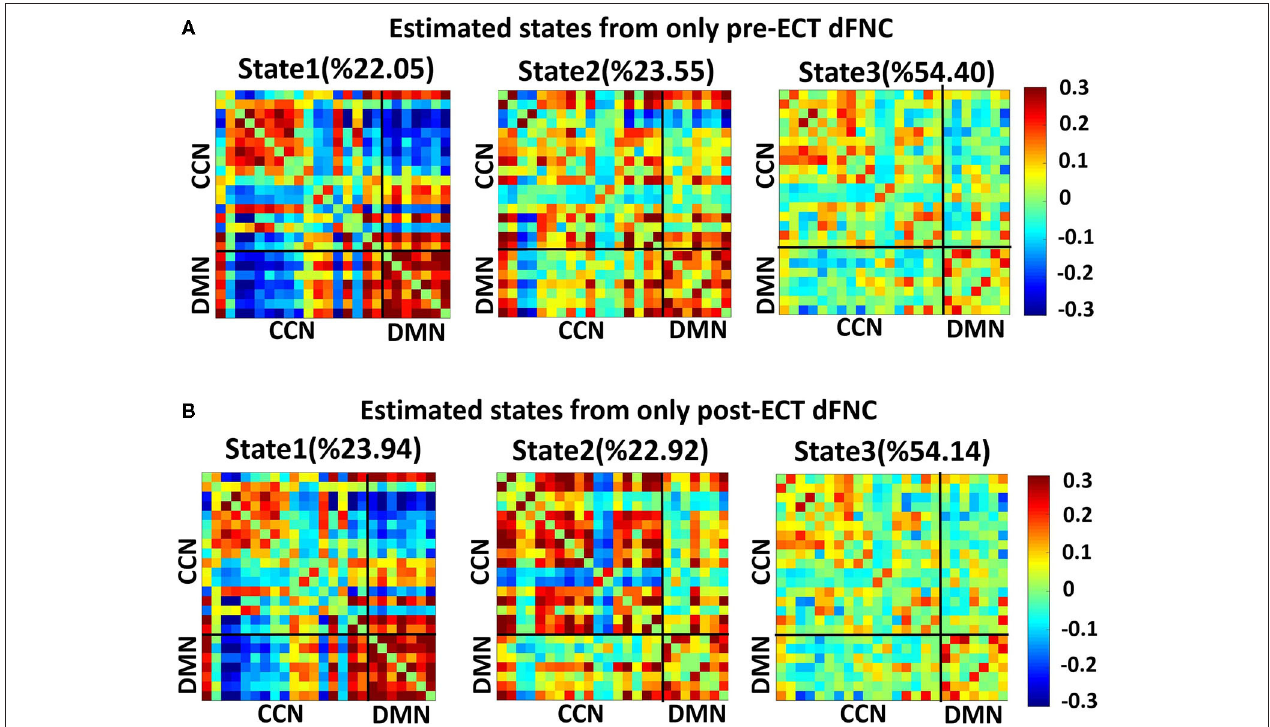
FIGURE 2 | Dynamic functional connectivities in three identified states, using the clustering method, the input of clustering is combined with dFNC of all individuals (both HCs and DEPs). Each state consists of a 24 × 24 matrix where the positive connectivities are shown by hot color and negative connectivities are shown with cold colors. The values in parentheses show the overall percentage of time the participants spent in each specific state. (A) States resulted from clustering analysis of pre-ECT dFNC. (B) States resulted from clustering analysis of post-ECT dFNC.